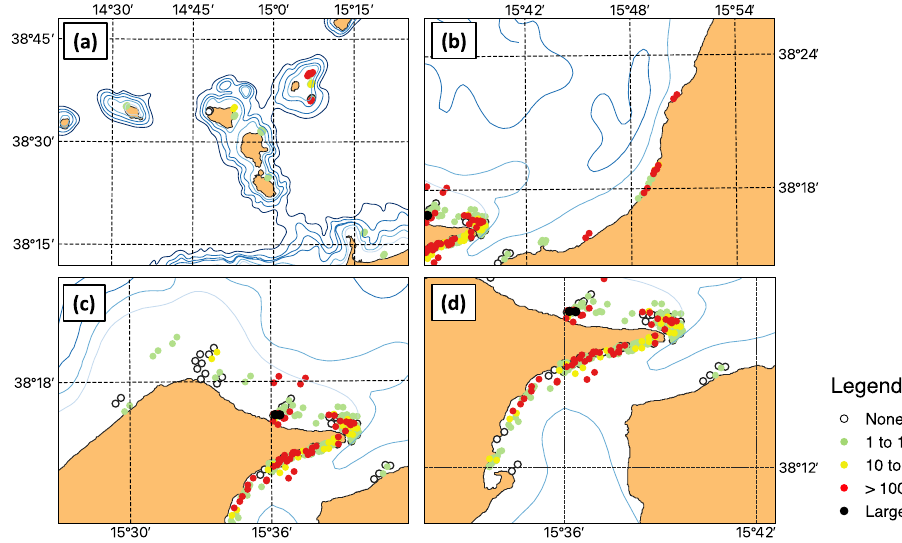
Figure 6. Presence and abundance patterns of Pelagia noctiluca specimens in the study area as observed during the 181 surveys of the fishing boat “Suerte” in the period March 2015–January 2016. Abundance classes are in agreement with 62 . Maps were generated with QGIS v. 3.22.6-Białowieża (https:// qgis. org/ it/ site/) under GNU General Public License. Coordinate Reference System: EPSG:4326 (WGS84).